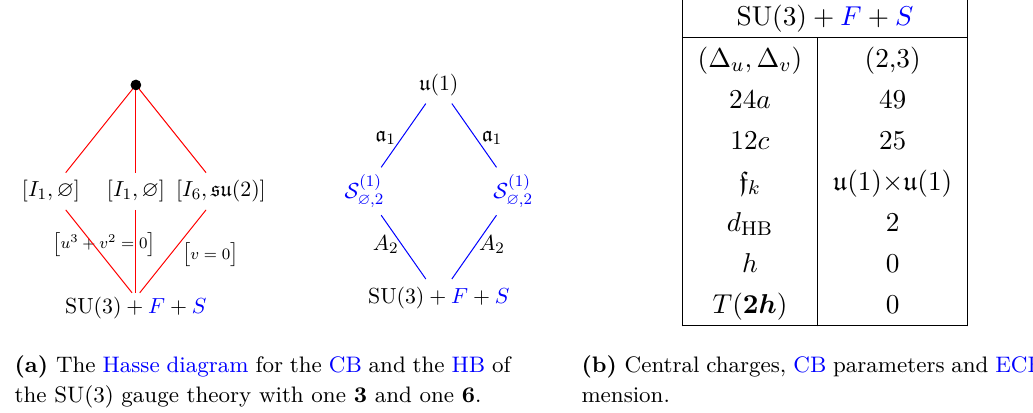
Figure 27. Information about the SU(3) N = 2 theory with one hypermultiplet in the 3 and one in the 6